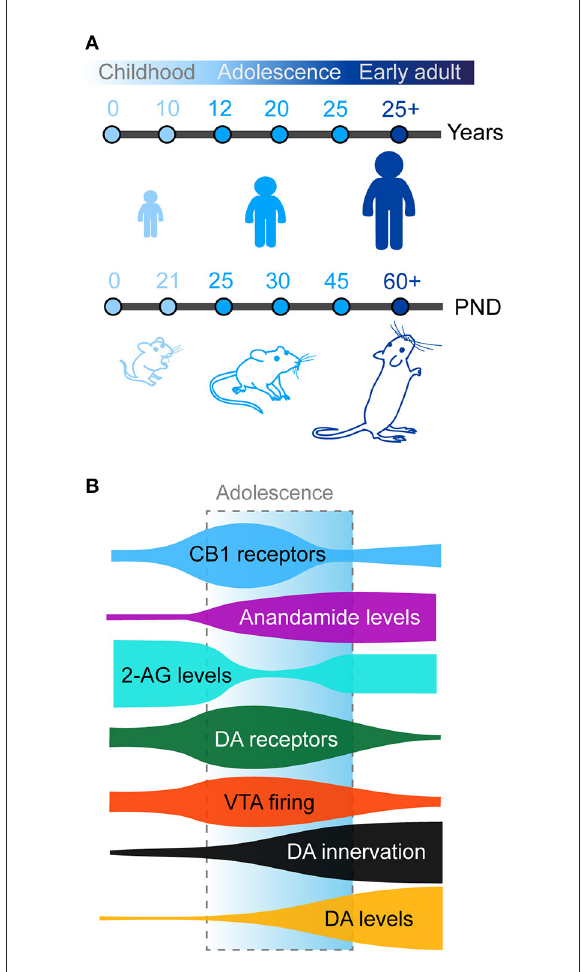
FIGURE1 (A) Timing of adolescence in humans (top) and rodents (bottom). Adolescence and peri-adolescence are defined as beginning around the age 10 years and continuing until the mid-20’s in humans and from post-natal day (PND) 21 to PND 50-60 in mice and rats. (B) Maturation of prefrontal dopamine (DA) and endocannabinoid systems across development. Schematic shows density of prefrontal anandamide (purple), dopamine (DA) tissue concentration (orange), and DA fibers (black) steadily increase from childhood to adulthood. Meanwhile, both CB1 (blue) and dopamine receptors (green) present a transient peak of expression in the prefrontal cortex during early adolescence, paralleled with similar changes in the activity of dopamine neurons in the VTA (red). Finally 2-AG levels (cyan) transiently decreases compared to childhood before returning to stable adult